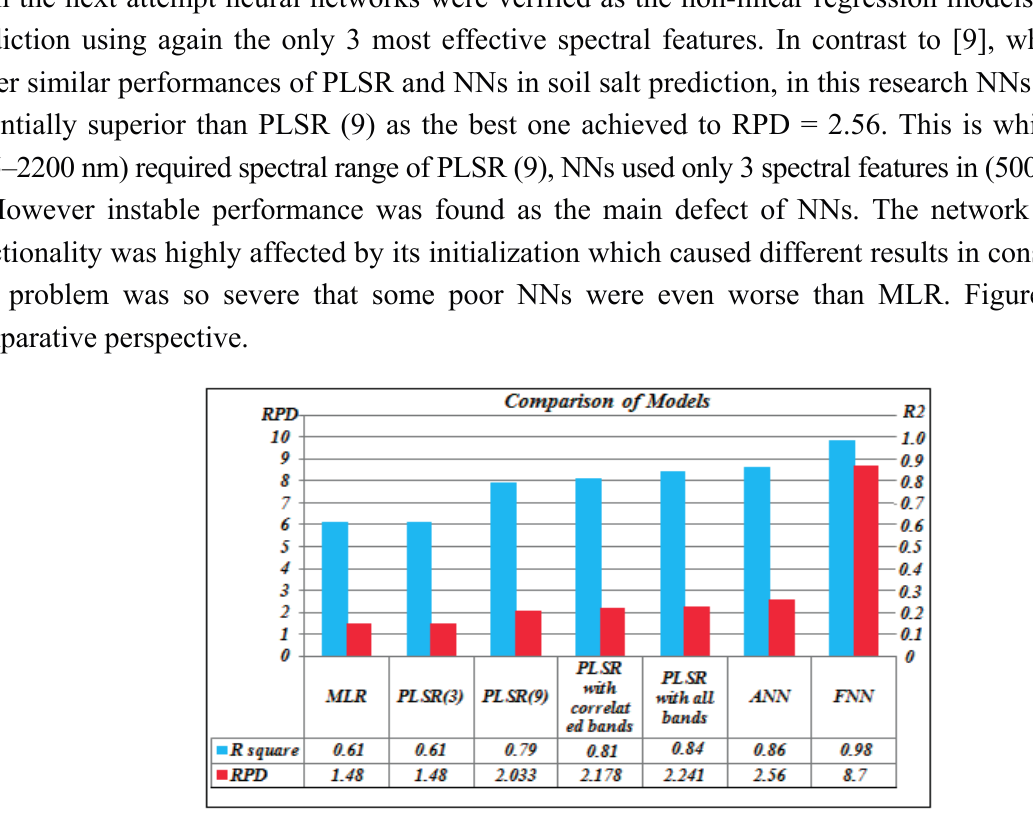
Figure 10. The comparison of different applied regression models in terms of R 2 and